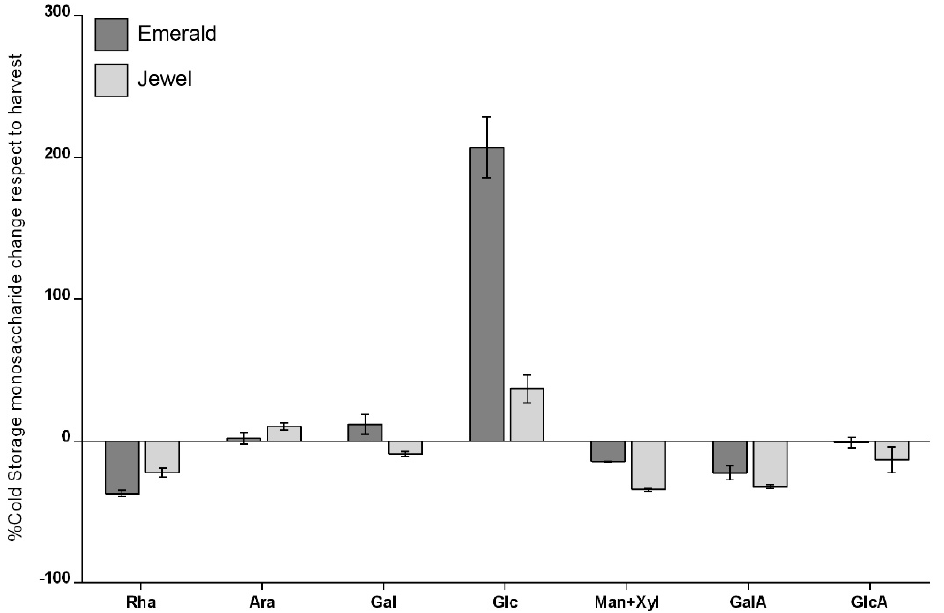
Figure 2. Changes in cold storage stage of cell wall monosaccharide composition percentage with respect to harvest stage. Error bars represent SEM (n = 6).